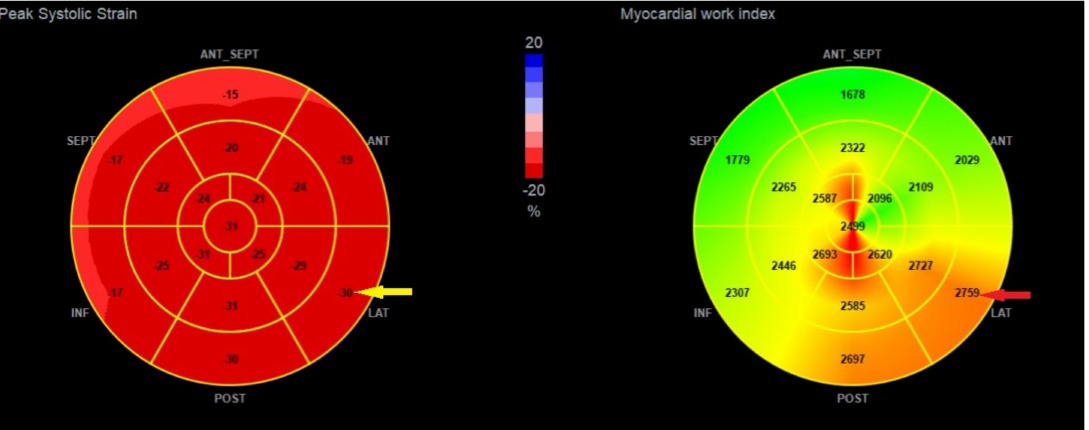
Figure 7. The example of the “Bull’s-eye” representation (obtained from long-axis, 2- and 4-chamber apical views) of regional strains in the MAD+ patient. Arrows present basal lateral segment with augmented (more negative) values of longitudinal strain (yellow arrow) and myocardial work index (red arrow).